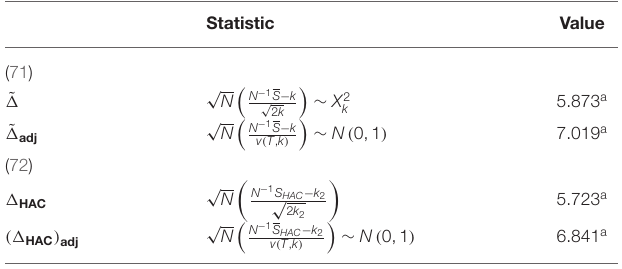
Cross–Sectional IPS (CIPS) test